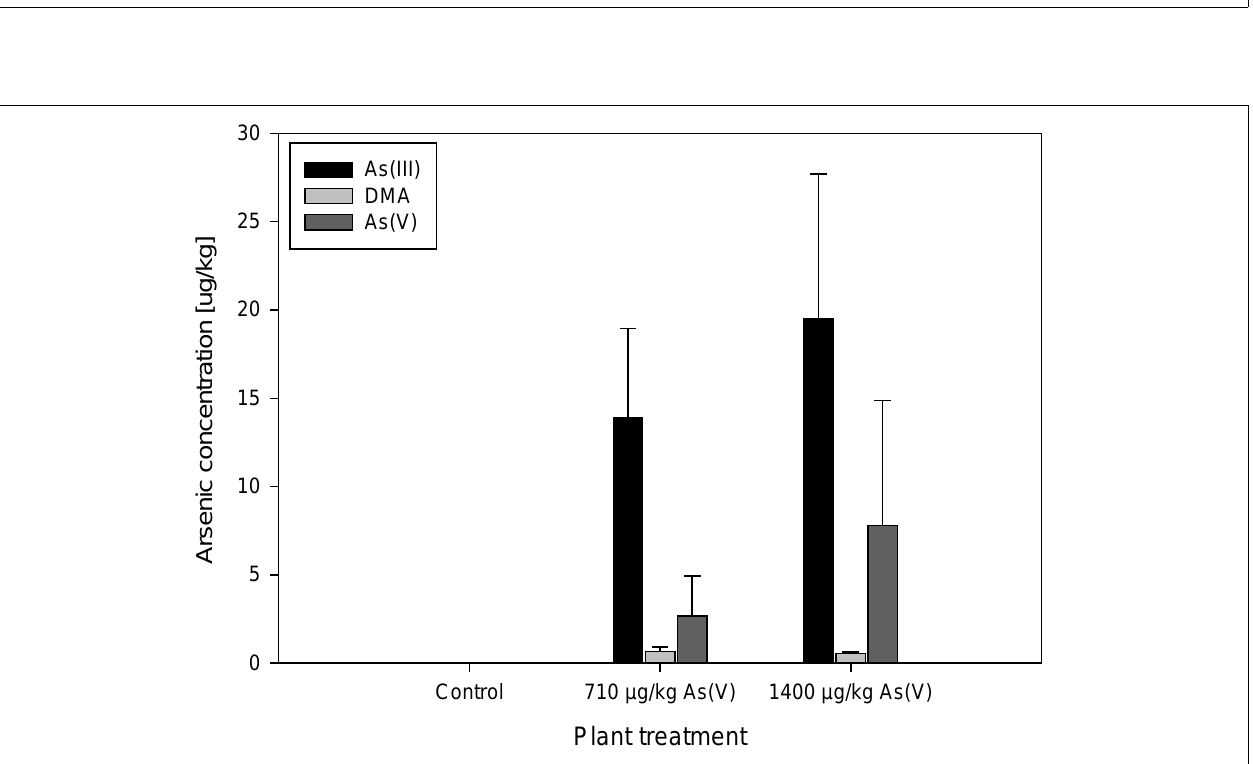
FIGUREA16 | HPLC–ICP-MS chromatograms of xylem sap samples of plants challenged with DMAV 1000 μ g/kg,AsV 100, 500, and 1000 μ g/kg, respectively for 24h. Chromatograms are shifted for clarity (Plant set C).